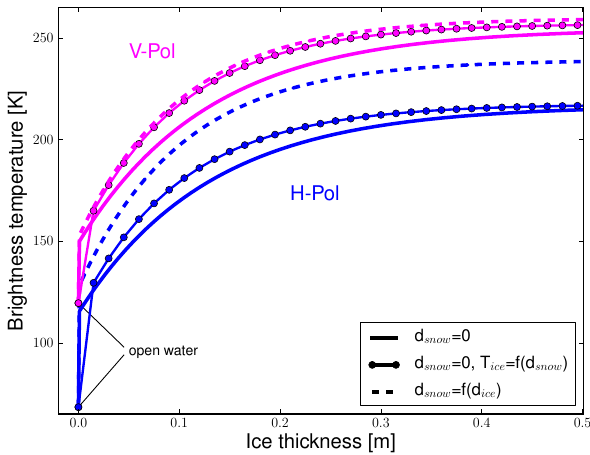
Fig. 1. Brightness temperature at horizontal (blue) and vertical (ma- genta) polarisation for an incidence angle θ = 45 ◦ as a function of ice thickness for three different scenarios: (1) the solid lines show brightness temperatures as modelled for snow-free sea ice; (2) the circles show brightness temperatures as modelled for snow-free sea ice with ice temperatures, as if the snow cover was present; and (3) the dashed lines show brightness temperatures as modelled for snow-covered sea